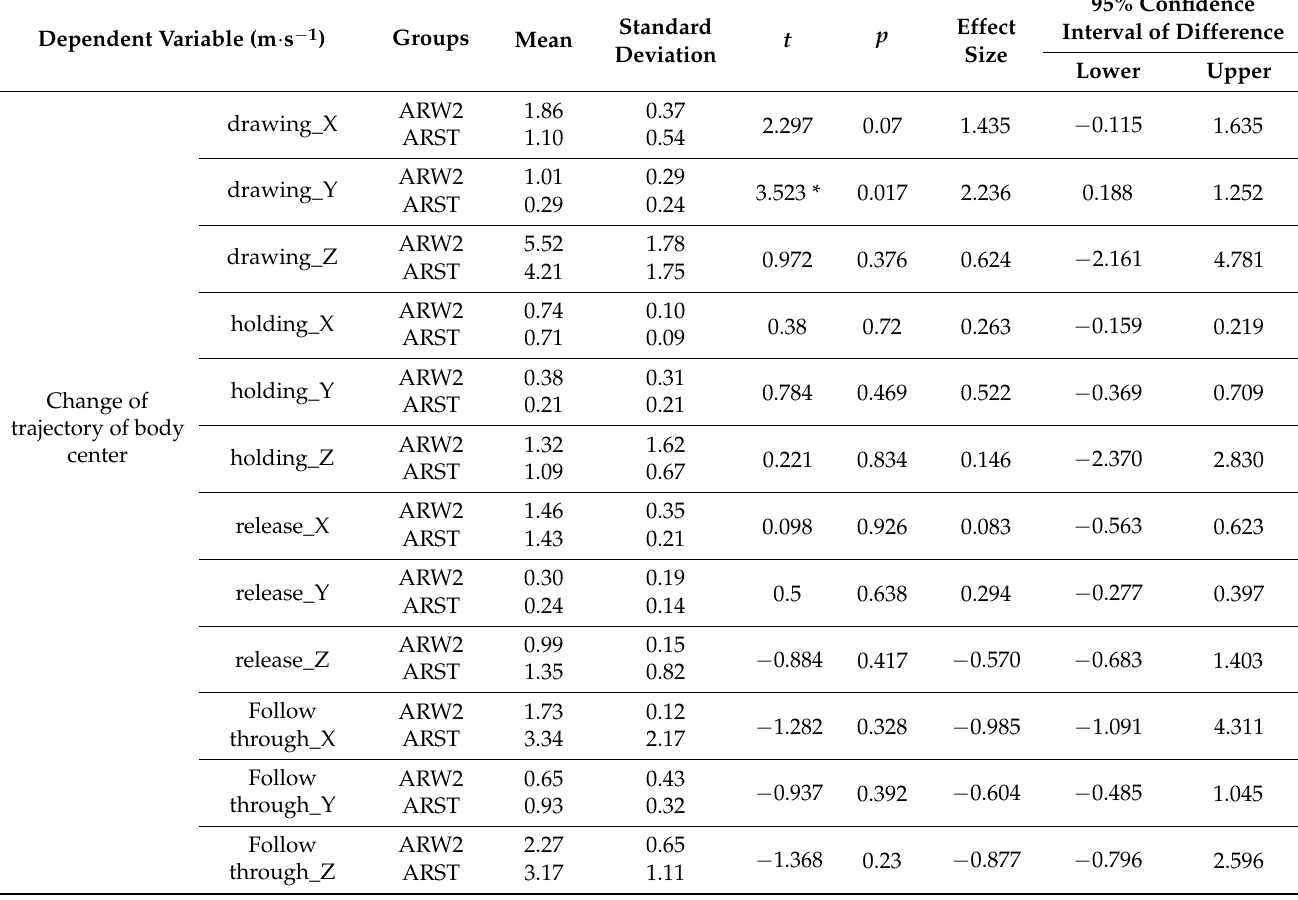
Table 5. Change of trajectory of the body